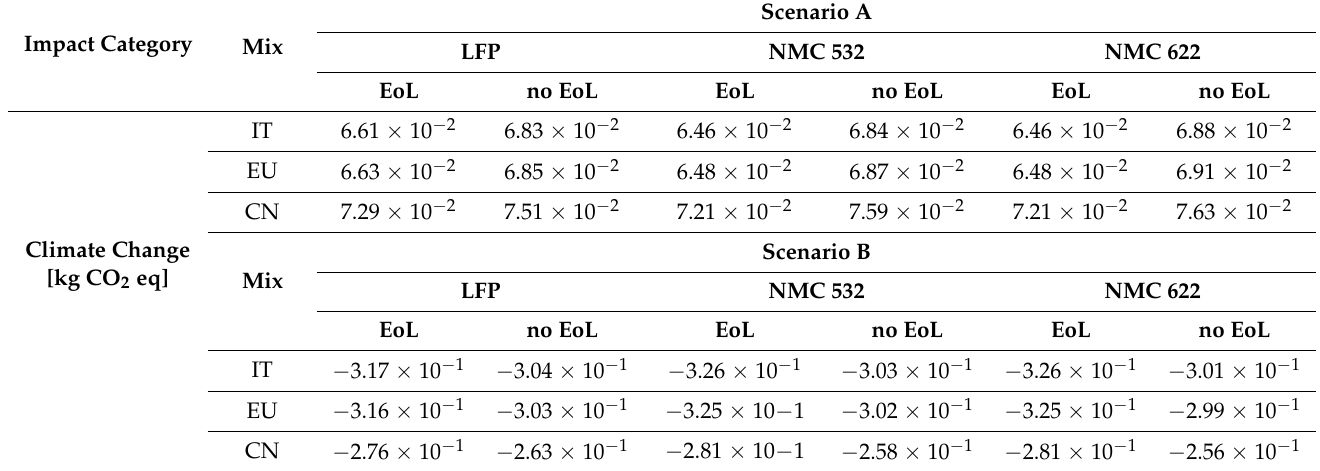
Table 11. Impact assessment results for the climate change category (kg CO 2 eq) for the different batteries while considering the following energy mixes: Italy (IT), Europe (EU), and China (CN). Data refer to 1 kWh of energy released while considering the entire useful life of the